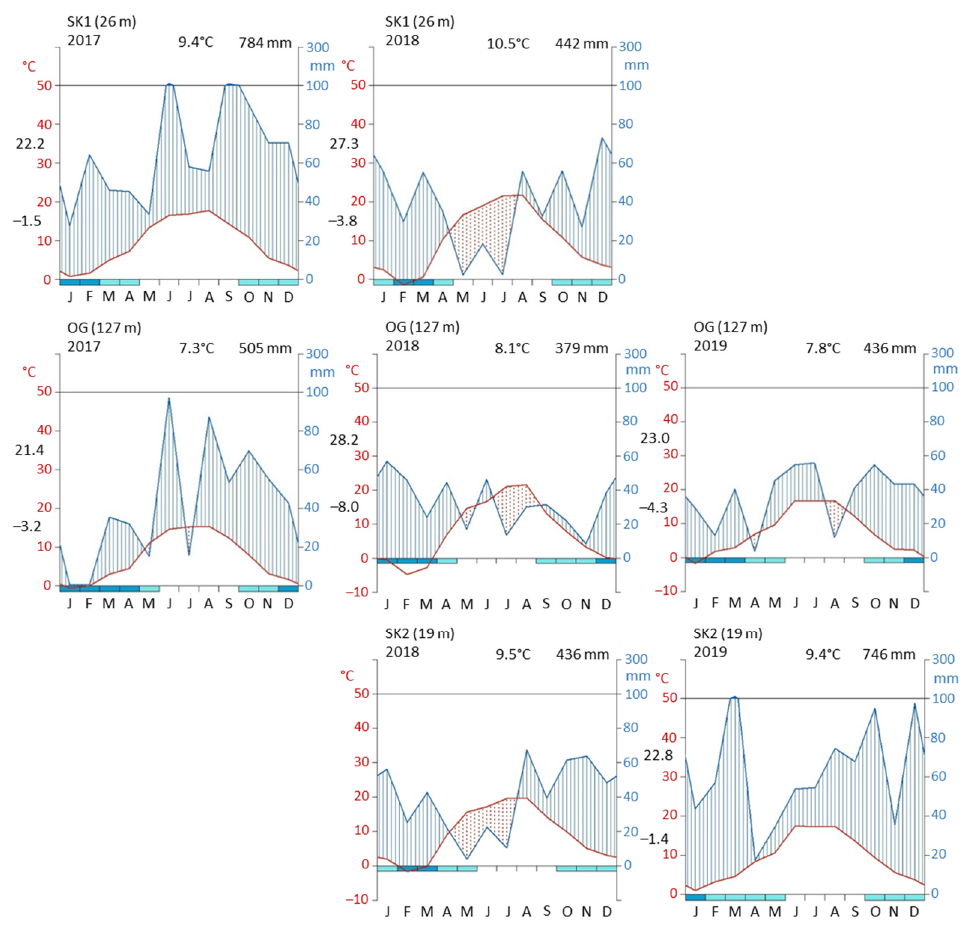
Figure 1. Meteorological data from the weather station closest to the experiments in SK and OG expressed in Walter–Leith graphs [20] for the three experimental years: 2017 at the top, 2018 in the middle, and 2019 at the bottom. The blue thick solid lines represent monthly precipitation, and the red solid lines represent average monthly temperature. The blue striped areas indicate excess water, and the red dotted areas indicate periods of (likely) water deficit, i.e., periods with precipitation less than two times the average monthly temperature. The number in parentheses after the site name is the altitude at the site. The numbers at the top are mean temperature of the year ( middle ) and accumulated precipitation during the year ( right ). The numbers to the left of the y-axes are the mean temperature of the warmest ( top ) and coldest ( bottom ) month. The dark turquoise boxes at the bottom indicate months when frost temperatures are common, and the light turquoise boxes indicate when frost could occur.